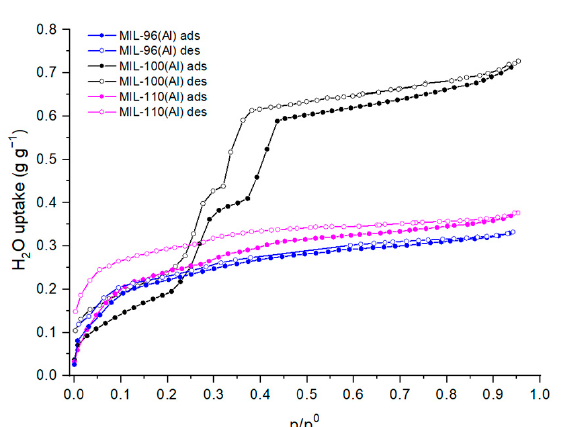
Figure 3. Water sorption isotherms of MIL-96(Al) (blue), MIL-100(Al) (black) and MIL-110(Al) (magenta) at 313 K ( left ) and ratio of water uptake to its maximum value in function of relative pressure ( right ). p/p 0 is the relative pressure of water with p 0 = 7.383 kPa (73.833mbar). Solid and open symbols denote adsorption and desorption,